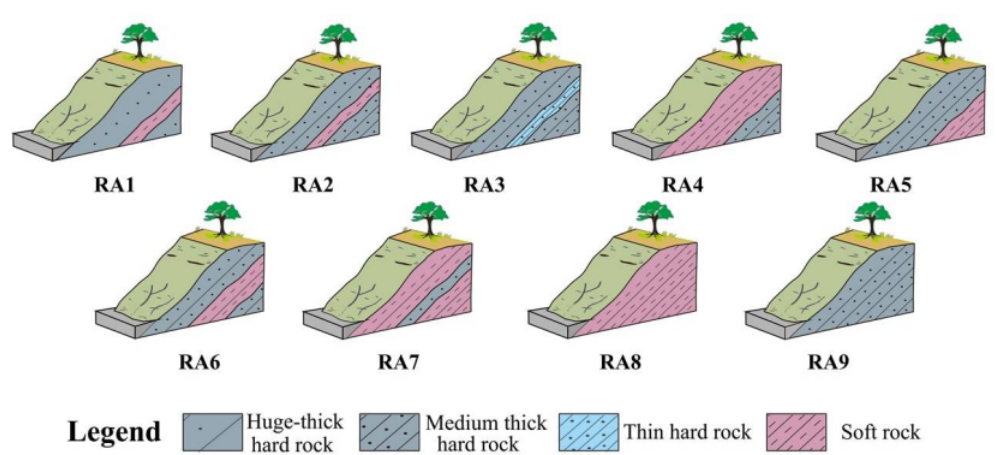
Figure 6. Classification of rock association (RA1:Huge-thick hard rock intercalated with soft layer. RA2: Medium-thick hard rock with soft rock. RA3: Medium-thick hard rock with thin hard rock. RA4: Upper soft rock and lower hard rock. RA5: Upper hard rock and lower soft rock. RA6: Interbedded soft and hard rocks. RA7: Soft rock as main hard rock. RA8 soft rock. RA9 hard rock).